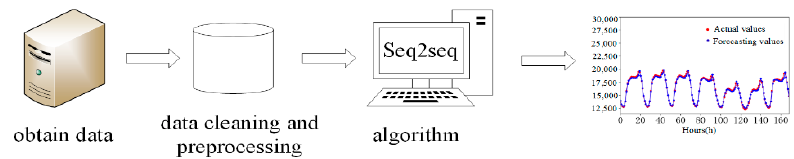
Figure 4. A short-term load forecasting model.